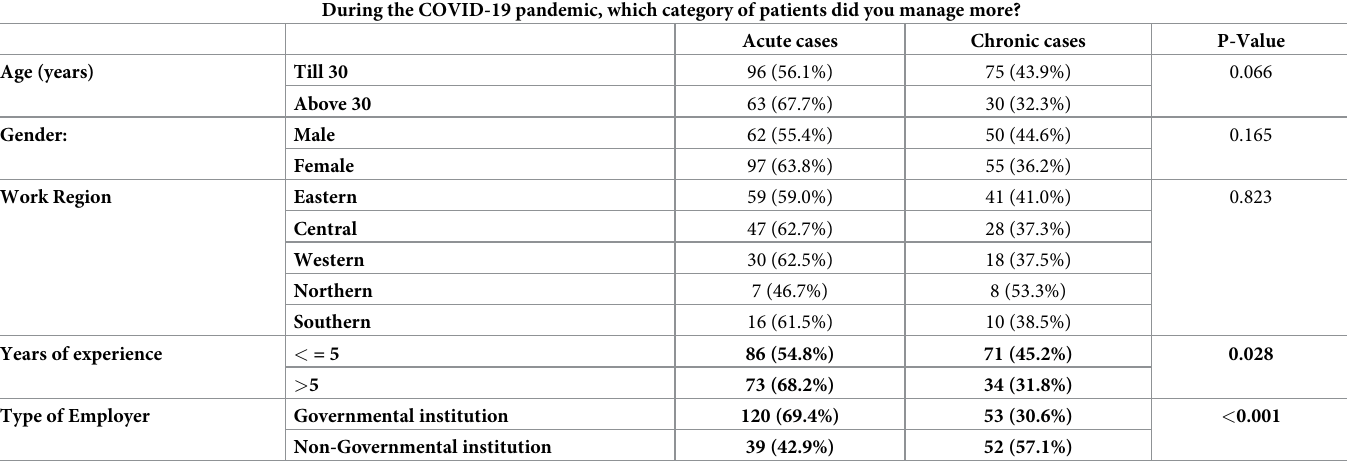
Table 4. Management of different patients by physiotherapist. During the COVID-19 pandemic, which category of patients did you manage